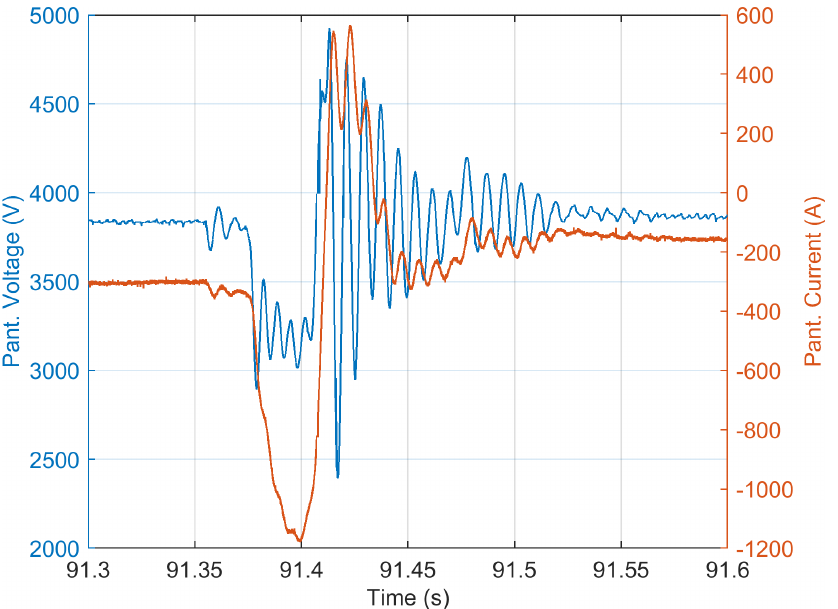
Figure 7. Combined onboard+TPS filter oscillation following an electric arc event in a DC rolling stock (from